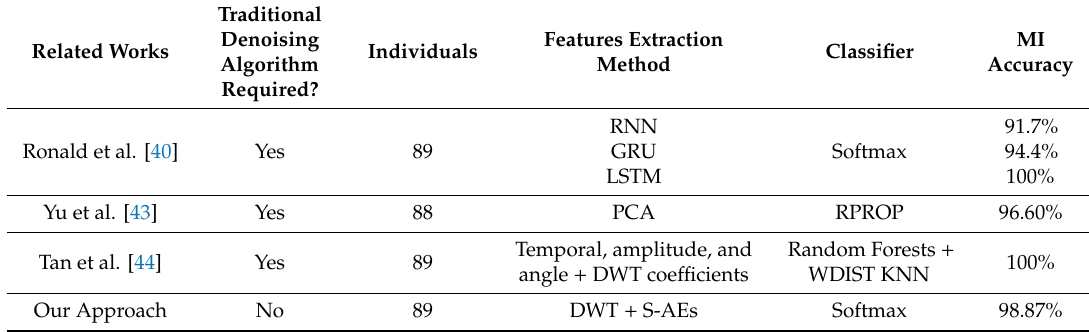
Table 6. Comparison with existing literature on ECG biometric identification using the ECG-ID (Two-recording).